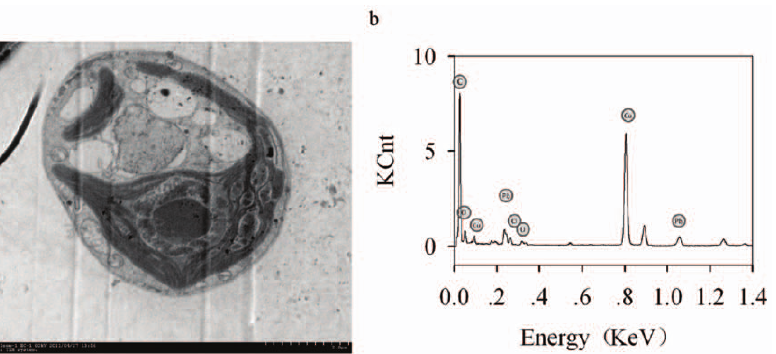
Figure 5. A representative transmission electron microscope (TEM) image (a) and the elemental composition of the interesting spots on it (b), as investigated with an energy dispersive X-ray (EDX) spectrometer, for a cell slice of C.reinhardtii exposed to 100 mg/l TiO 2 -ENs but without any addition of Cd 2 + .